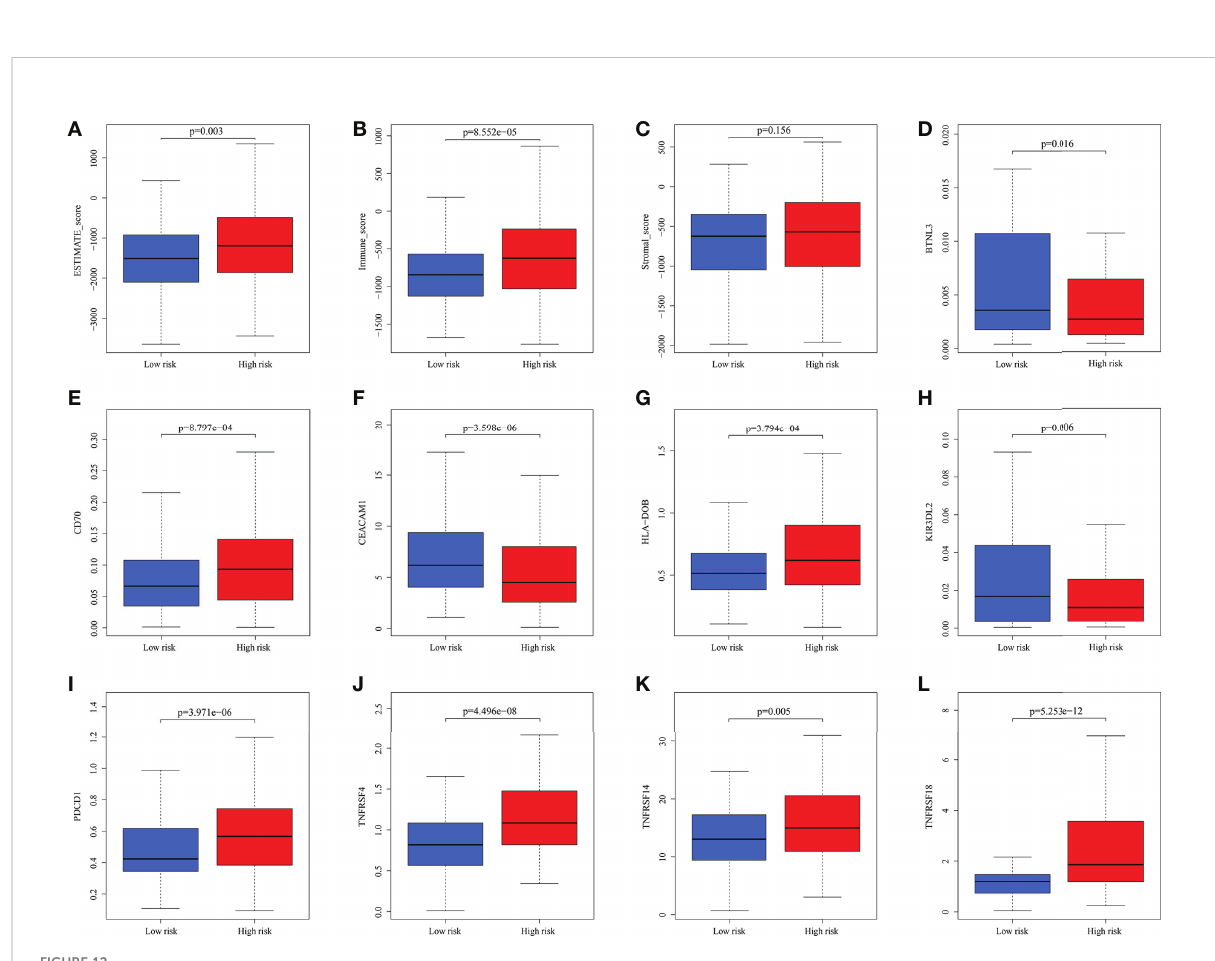
FIGURE 12 The analysis of immune scores and ICGs. (A-C) Pearson ’ s association analysis of ESTIMATE score, immune score and stromal score between subgroups. (D-L) Association analysis of some ICGs.